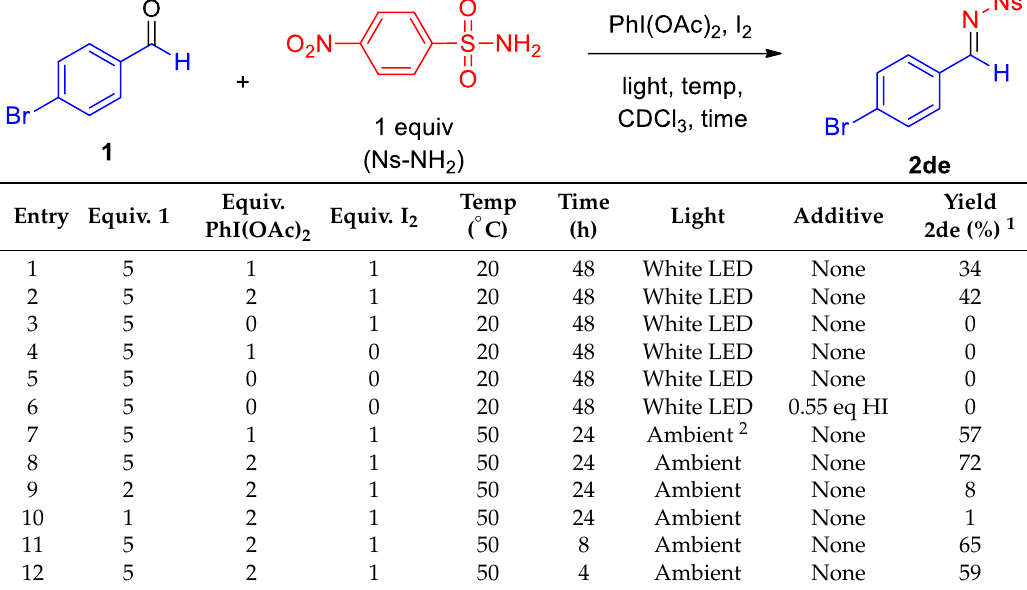
Molecules 2018 , 23 , x FOR PEER REVIEW 4 of 16